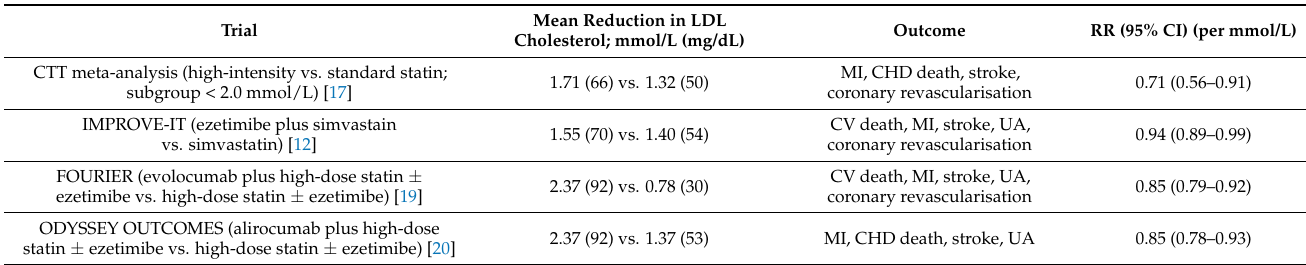
Table 1. Randomized cardiovascular outcomes study with high intensity LDL-lowering therapy in patients with coronary artery